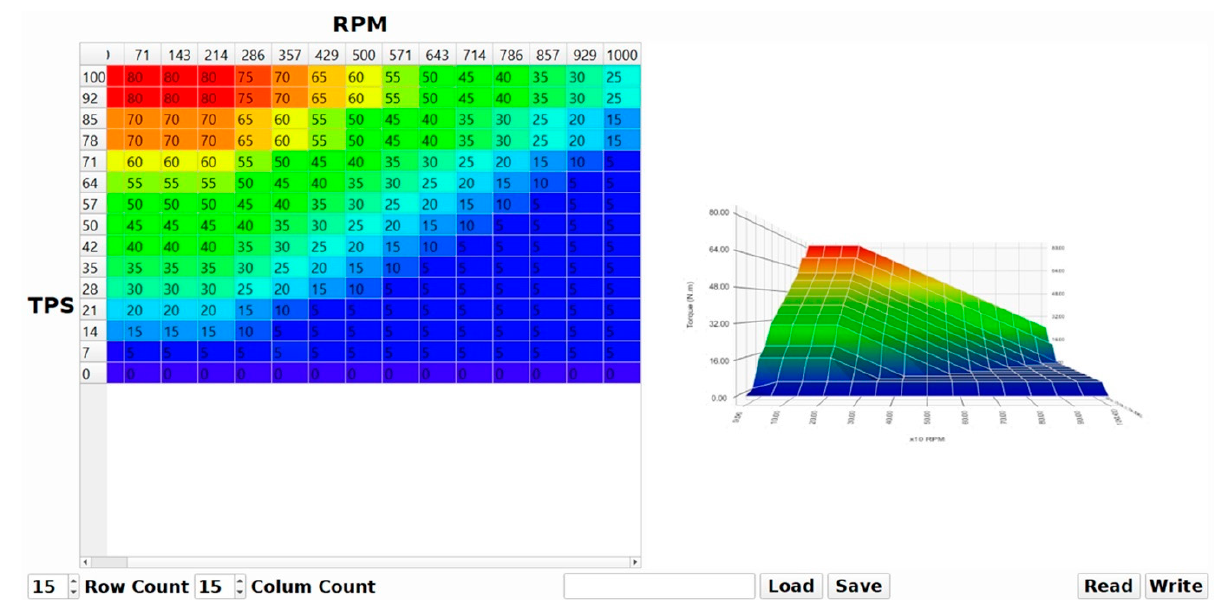
Figure 15. Snapshot of the lookup table interface of the controller software.